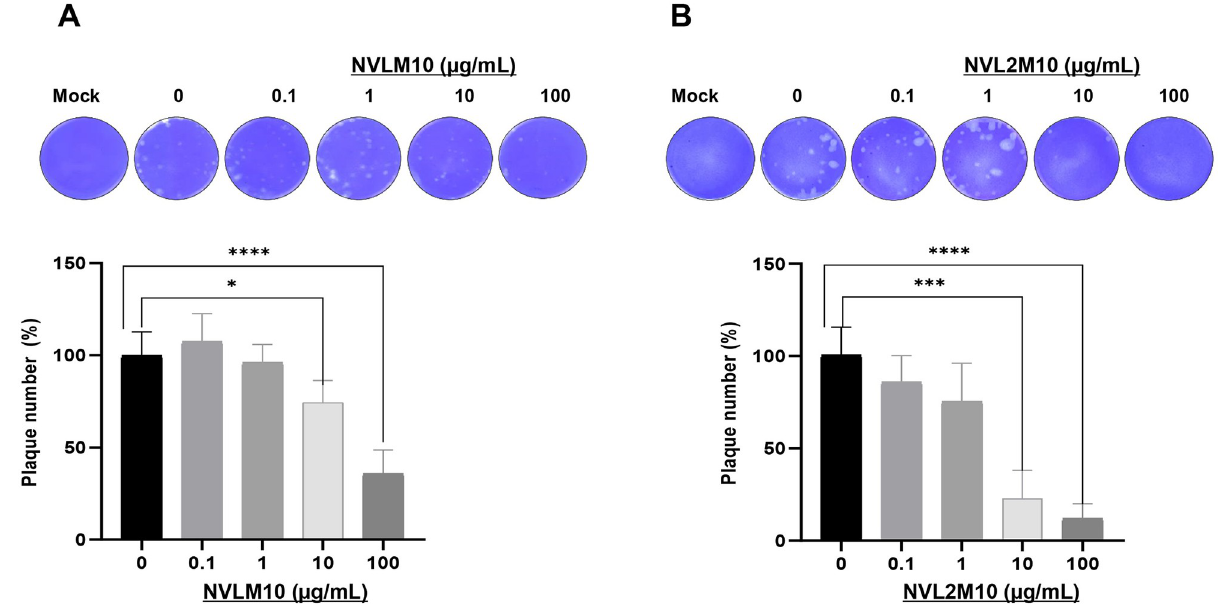
Fig 6. Neutralization activity to influenza virus infection of the NVLM10 and NVL2M10 in vitro . Influenza H1N1/PR8 virus infection in MDCK cells was neutralized in a treatment of serially diluted concentrations (0, 0.1, 1, 10, 100 μ g/mL) of (A) NVLM10 or (B) NVL2M10 through plaque inhibition assay. Plaques were counted and represented as a plaque number percentage. Statistical significance was determined by unpaired t test ( � p < 0.05, ��� p < 0.0005, ���� p < 0.0001).